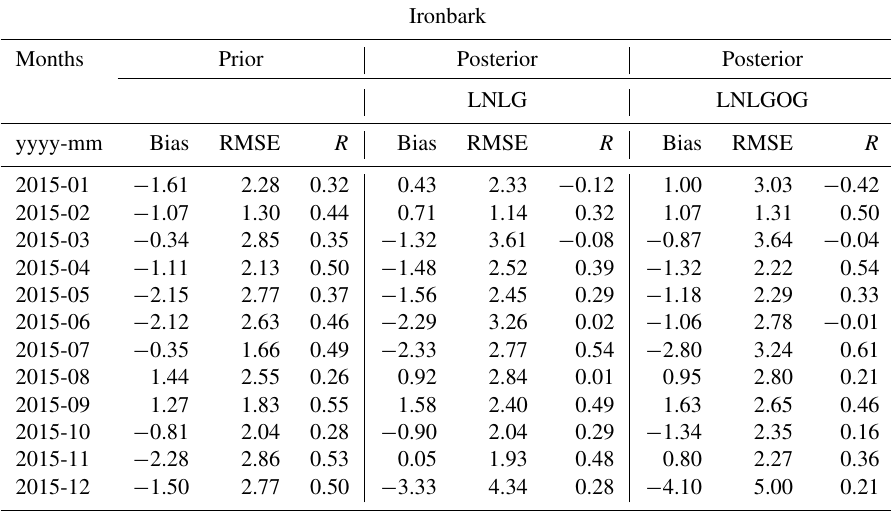
Table H2. Analysis of the residual between CMAQ prior and posterior simulations and the Ironbark site for 2015: averaged bias, RMSE and Pearson’s coefficient ( R ).